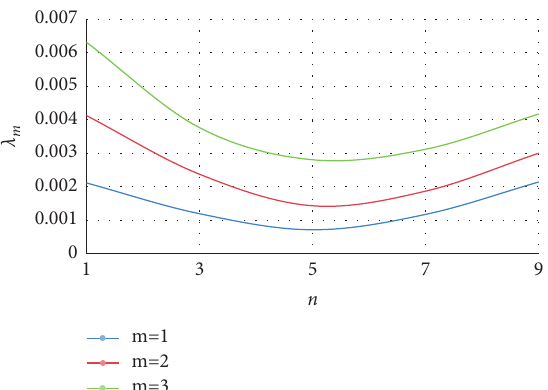
Figure 7: Relationbetweenfrequencyandcircumferentialnodenumberoffive-layeredshells0 0 /90 0 /0 0 /90 0 /0 0 ( EGE / KE / EGE / KE / EGE ) ; L � 0 . 5.